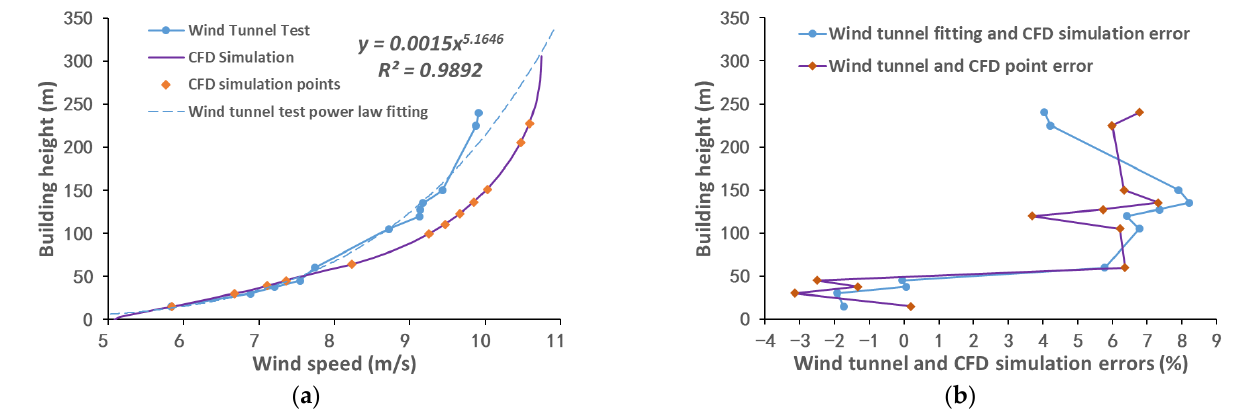
Figure 6. Wind tunnel test, air velocity CFD simulation, and error distribution. ( a ) Air velocity distribution and ( b ) Error distribution.